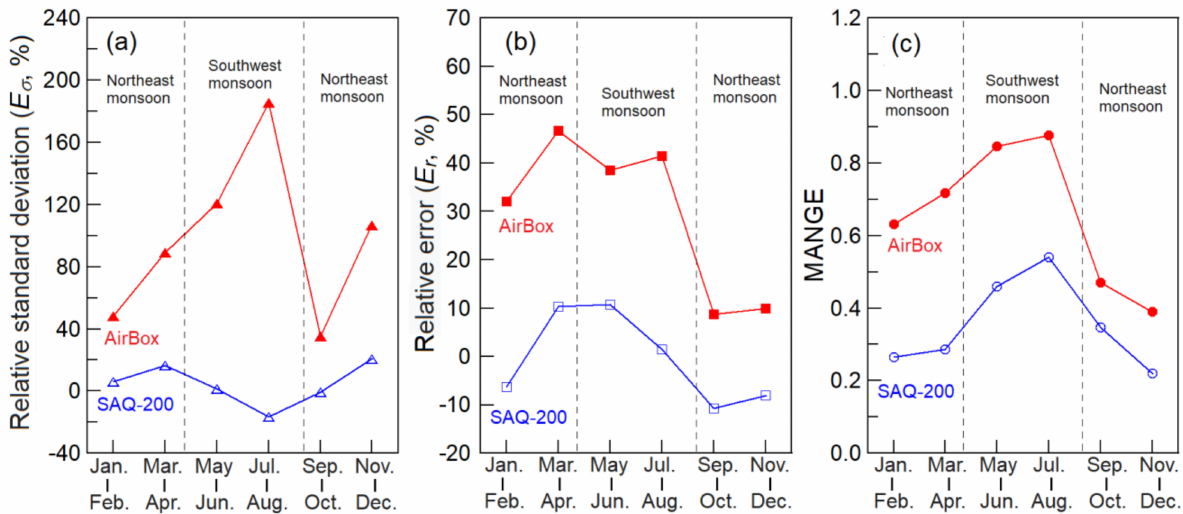
Figure 7. The variations of ( a ) relative standard deviation, ( b ) relative error, and ( c ) MANGE of the two low-cost PM 2.5 sensor systems during periods 1 − 6 of